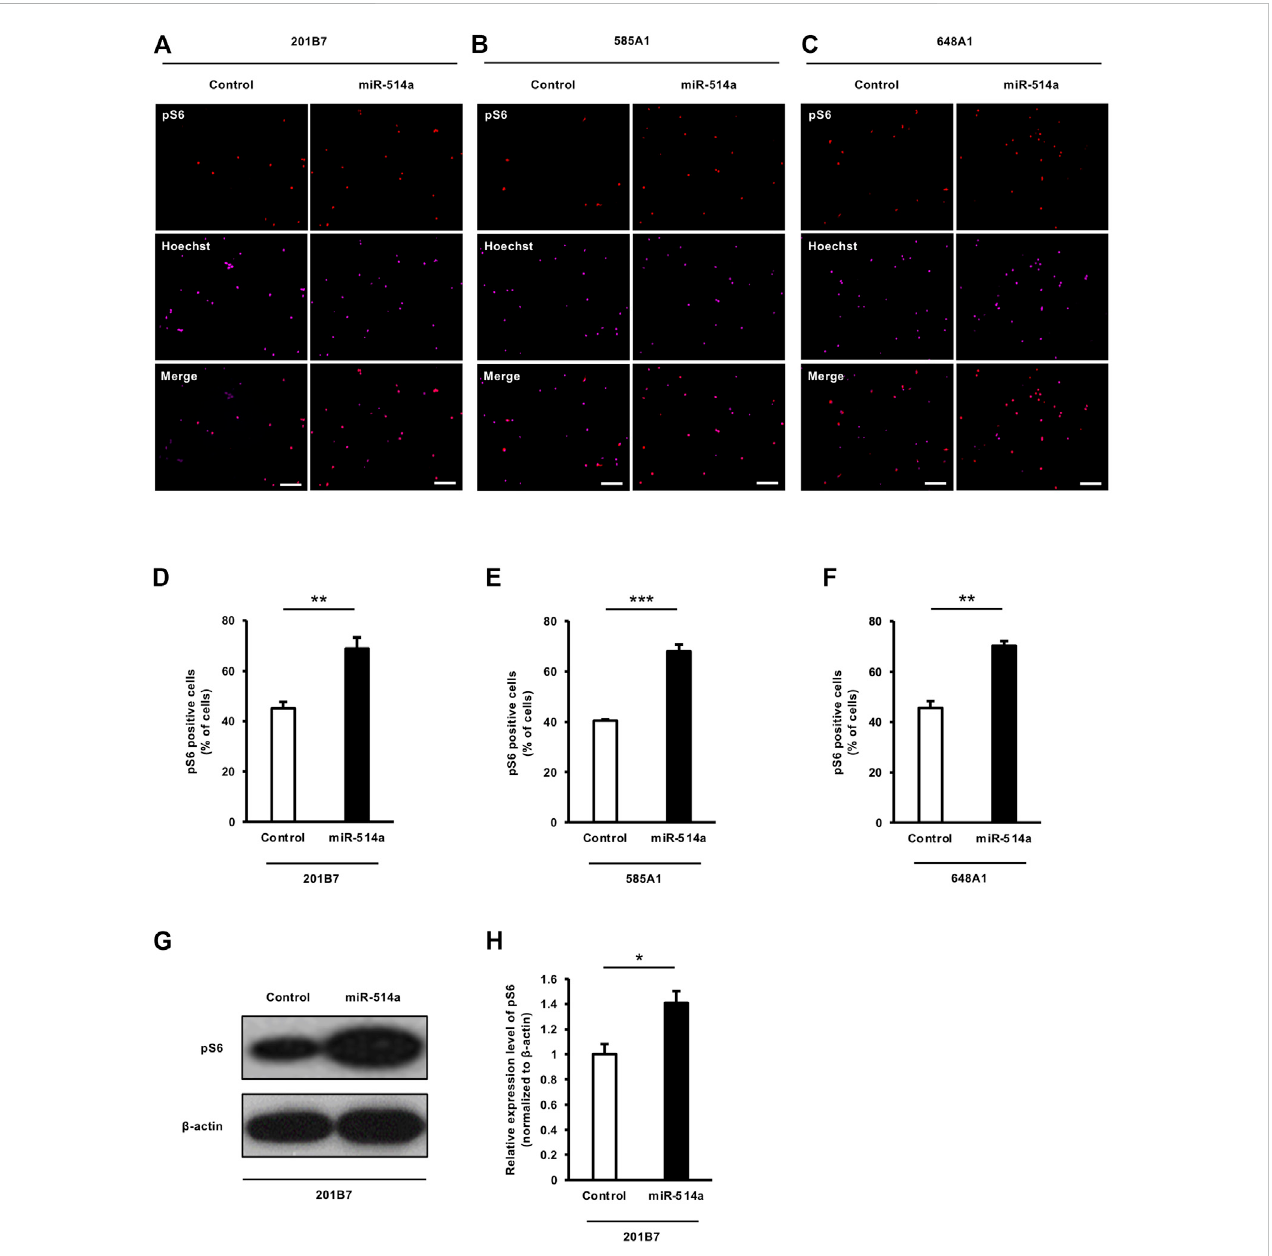
FIGURE 4 miR-514a upregulates mTOR signaling pathway in human iPSC-derived neurons. Neurons were infected with lentiviruses expressing miR-514a and cultured for 7 days. (A – C) Representative images of iPSC-derived neurons stained with anti-pS6 (red) antibody and Hoechst 33,258 (magenta) at 7 DIV. Scale bars, 100 µm. (D – F) pS6 positive neurons derived from three independent iPSC line, respectively, were quanti fi ed. mTOR activity was markedly increased in neurons expressed miR-514a. n = 3 independent experiments, at least 200 neurons were analyzed in each experiment. (G) Western blotting analysis showing the level of pS6 in cultured neurons at 7 DIV. (H) Quanti fi cation of pS6 level. n = 3 independent experiments. *** p < 0.001, ** p < 0.01, * p < 0.05. Abbreviations: pS6, phospho-S6 ribosomal protein.